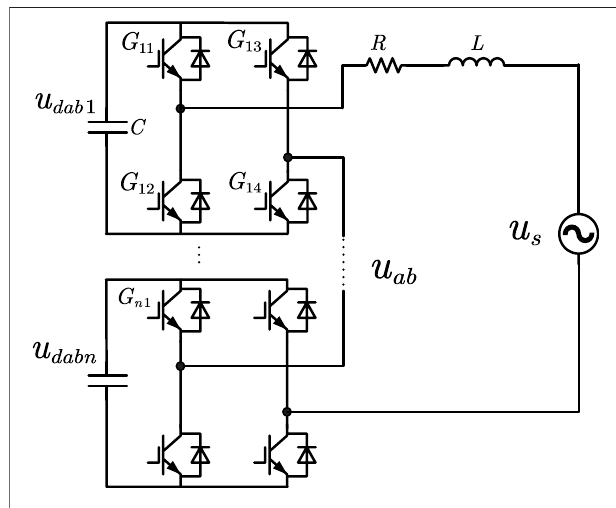
FIGURE 3 | Single-phase circuit structure